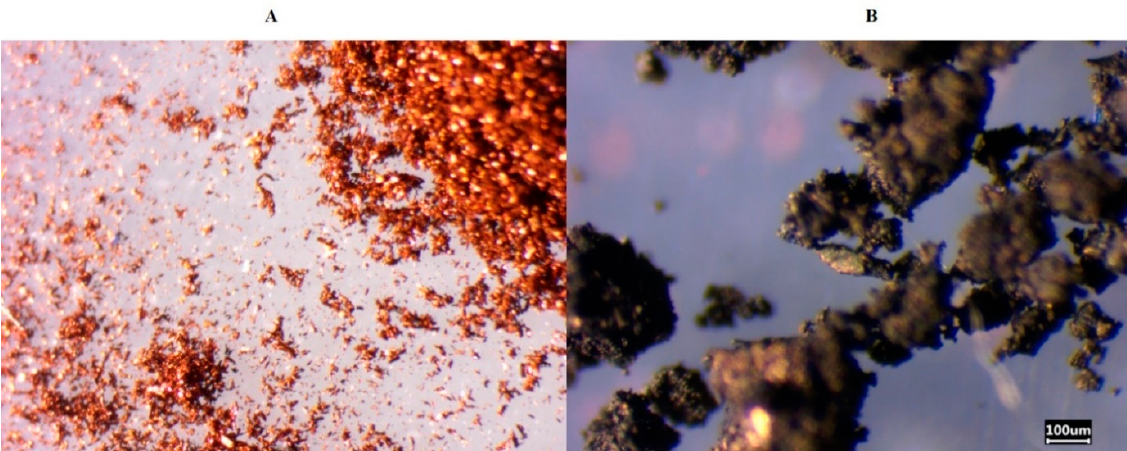
Figure 5. Photos of samples: ( A )—methylene blue; ( B )—polymethylene blue.